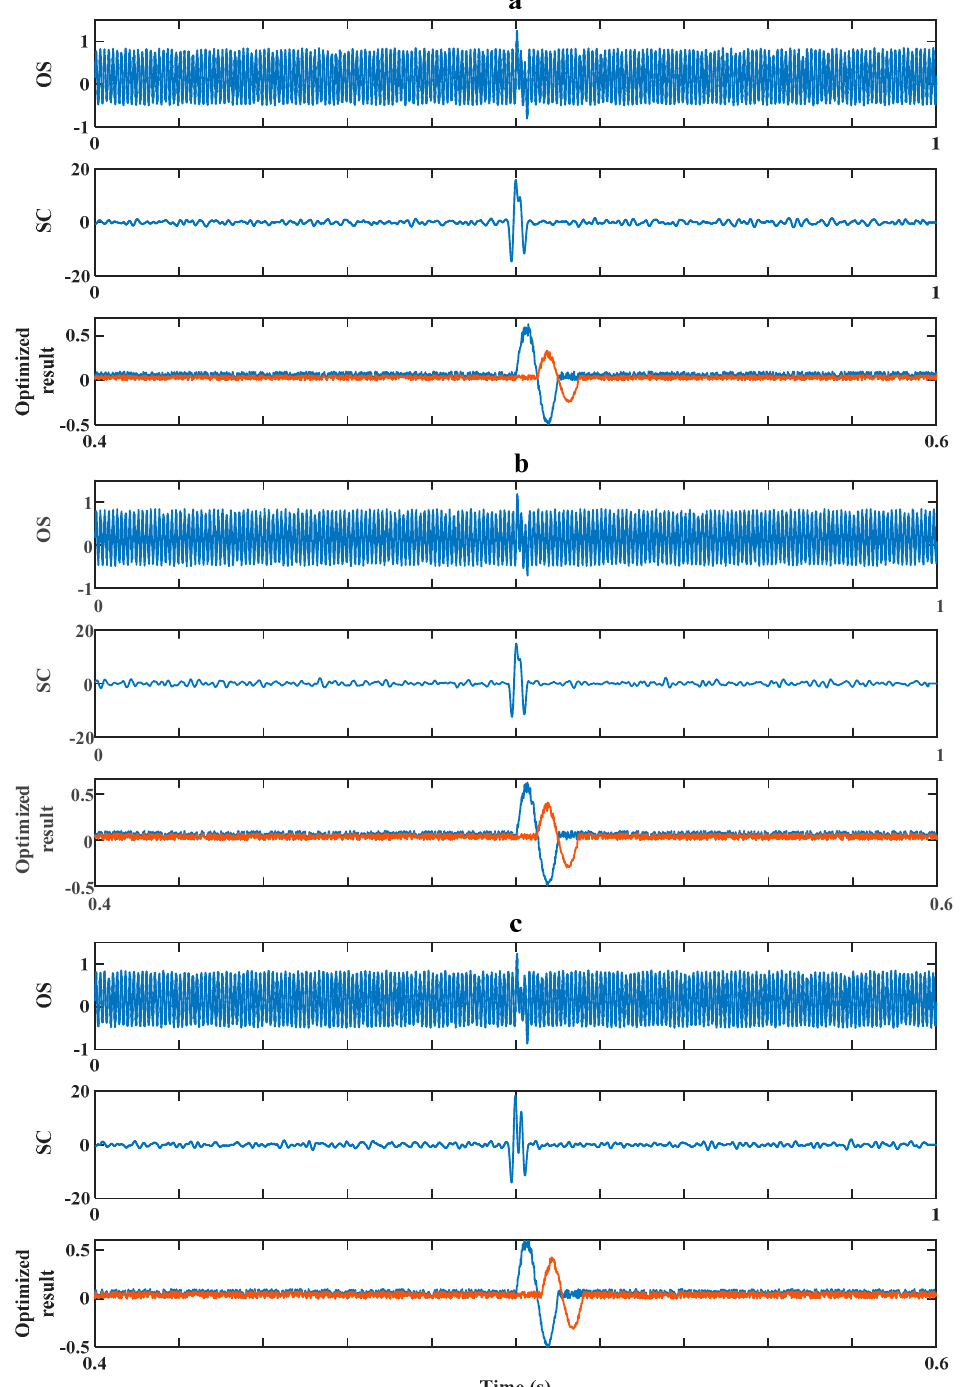
Figure 10. Method’s performance for signals of low SNR while k = 1.2. ( a ) ∆ t = 0.5 T . ( b ) ∆ t = 0.48 T . ( c ) ∆ t = 0.6 T .